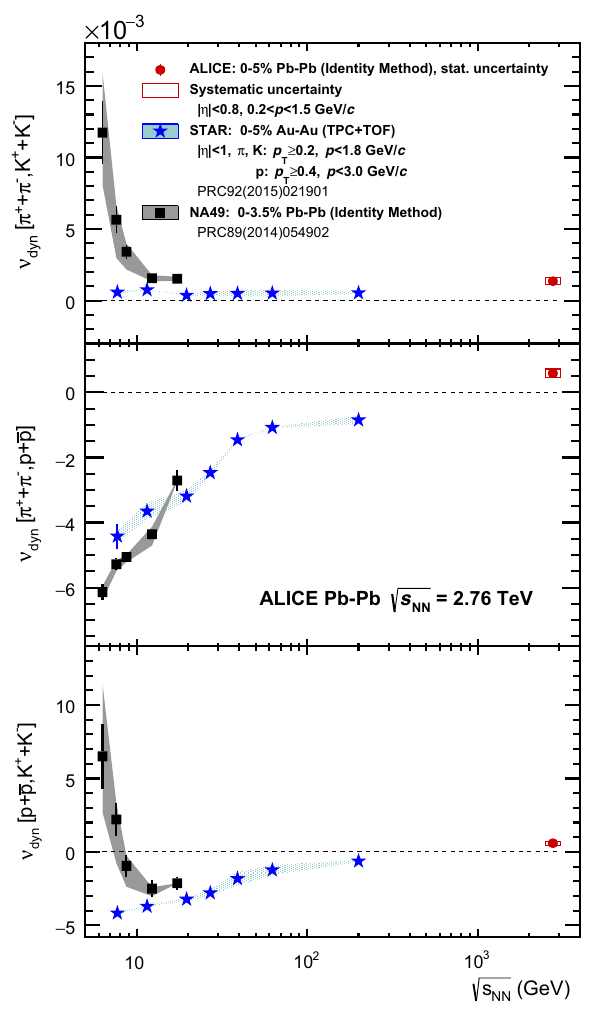
Fig. 4 Collision-energy dependence of ν dyn . Results obtained with the Identity Method in this work and by the NA49 collaboration [13] in Pb– Pb collisions are shown with red circles and black squares, respectively, while those obtained by the STAR collaboration [10] in Au–Au colli- sions are shown with blue